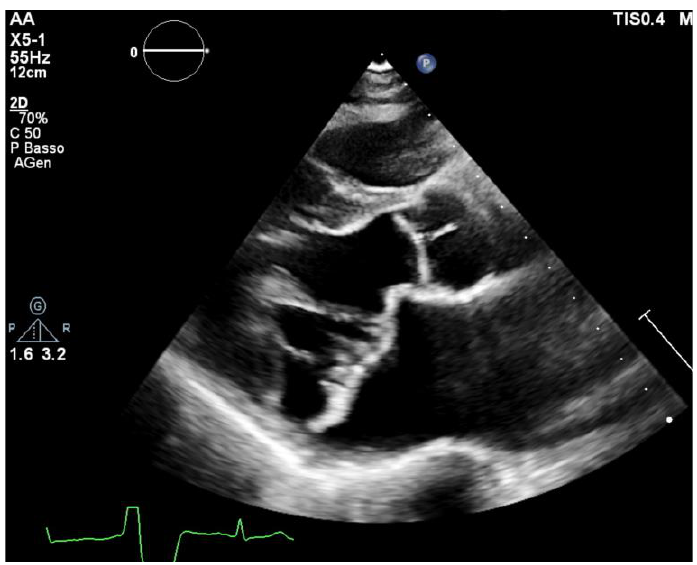
Figure 1. A parasternal long axis (PLAX) view of MVP in end-systole from a patient enrolled in the aMVP group. Note the prolapse of both leaflets above the mitral annulus plane.